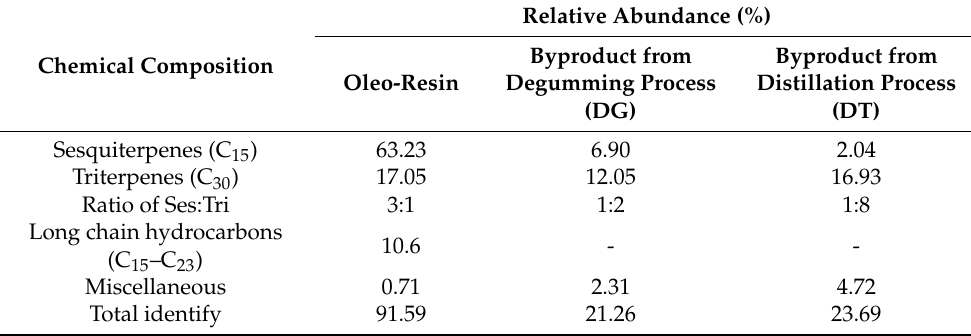
Table 2. Chemical composition of oleo-resin and resin from different preparation processes during GC-MS analysis.